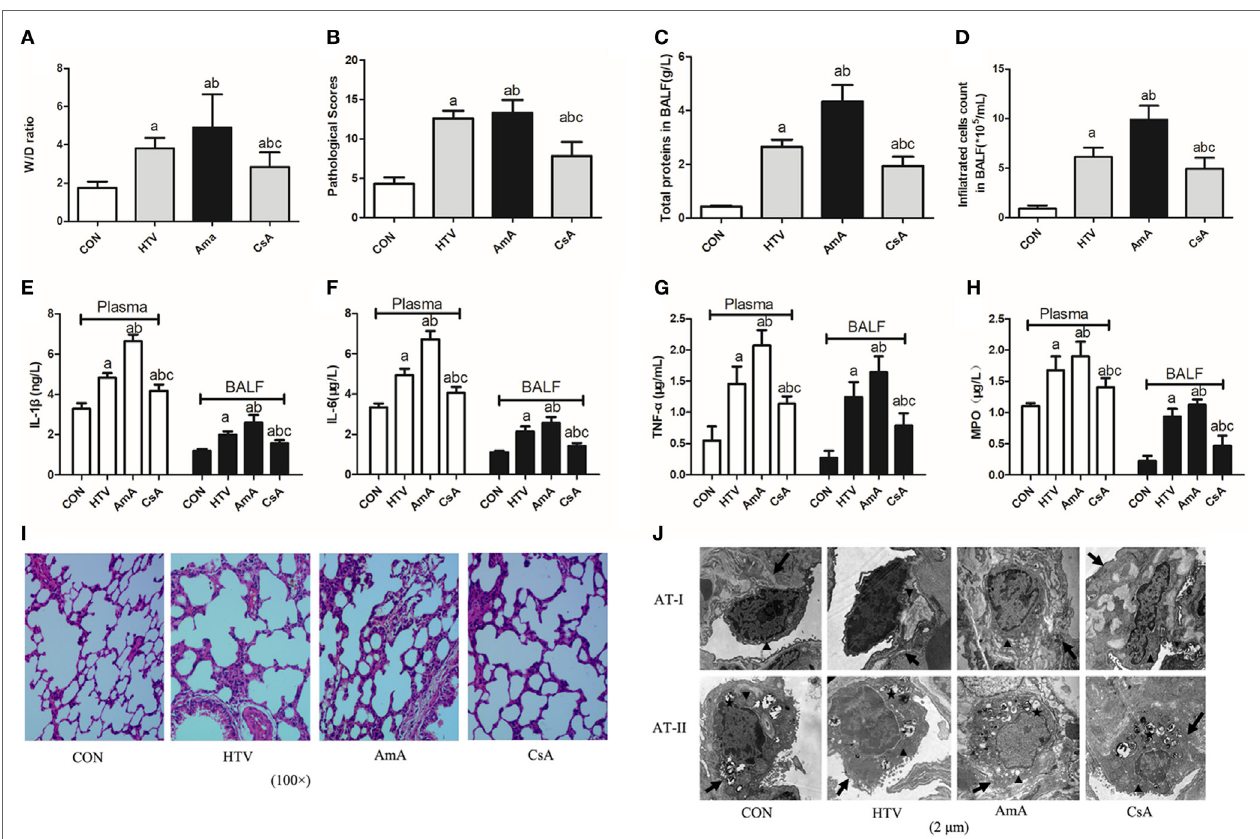
FigUre 6 | Lung injury and inflammation in animals with spontaneous breathing (CON) or mechanical ventilation at high tidal volume (HTV) with saline, antimycin A (AmA), or cyclosporine A (CsA). (a) Lung edema was assessed by determining the weight ratio between wet and dry lung (W/D). (B) Pathological score was assessed by result of hematoxylin and eosin (HE) staining. (c) Total protein concentration in bronchoalveolar lavage fluid (BALF). (D) Infiltrated cell counts in BALF. (e) Levels of interleukin (IL)-1 β in BALF and plasma. (F) Levels of IL-6 in BALF and plasma. (g) Levels of tumor necrosis factor (TNF)- α in BALF and plasma. (h) Levels of myeloperoxidase (MPO) in BALF and plasma. (i) Histology of lung tissue was stained with HE. Magnification, 100 × . (J) Transmission electron micrographs of alveolar cells. Areas marked with arrows signify continuous membrane and triangles mark areas of disrupted cytoplasmic and nuclear structure. Areas marked with stars represent the osmilphilic multilamellar bodies, the unique structure of AT-IIs. Tissue from CON group appeared normal, but tissue from HTV and AmA groups exhibited a disrupted cytoplasmic and nuclear structure, as well as cell membrane discontinuities. Moreover, the osmilphilic multilamellar bodies show characteristic vacuolation in the HTV and AmA groups. But these effects were attenuated when administered in the presence of CsA. Magnification, 20,000 × . Both of these experiments were in triplicate. a P < 0.05 vs. CON group; b P < 0.05 vs. HTV group; and c P < 0.05 vs. AmA